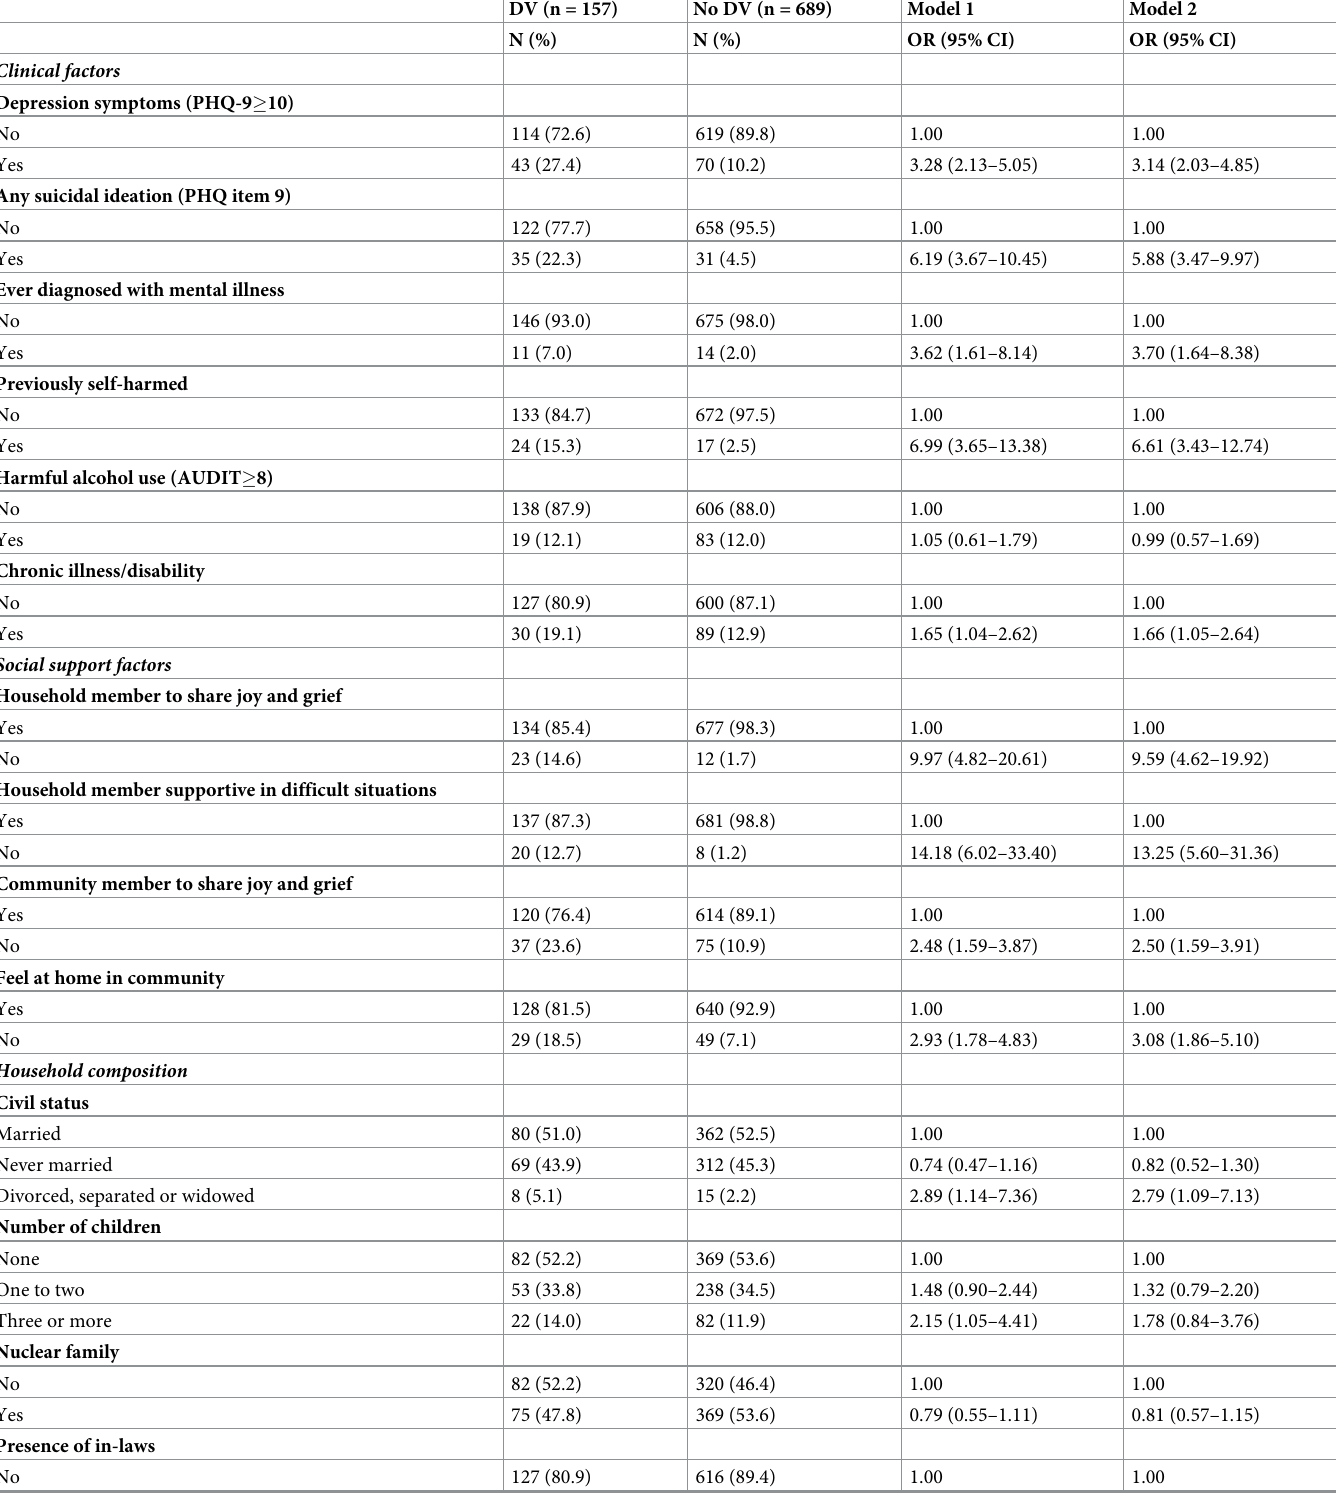
Table 2. Clinical and psychosocial factors associated with domestic violence (DV) in Kandy, Sri